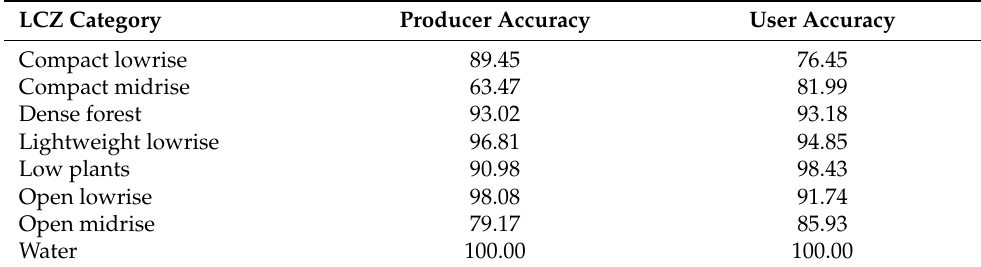
Table 1. Accuracy of LCZ classification.